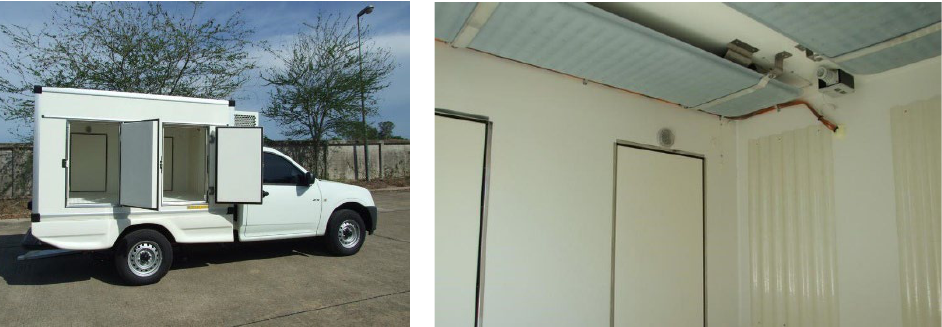
Figure 11. PCM filled metallic plates mounted in a van for cooling (source: both PLUSS Advanced Technologies Ltd.).